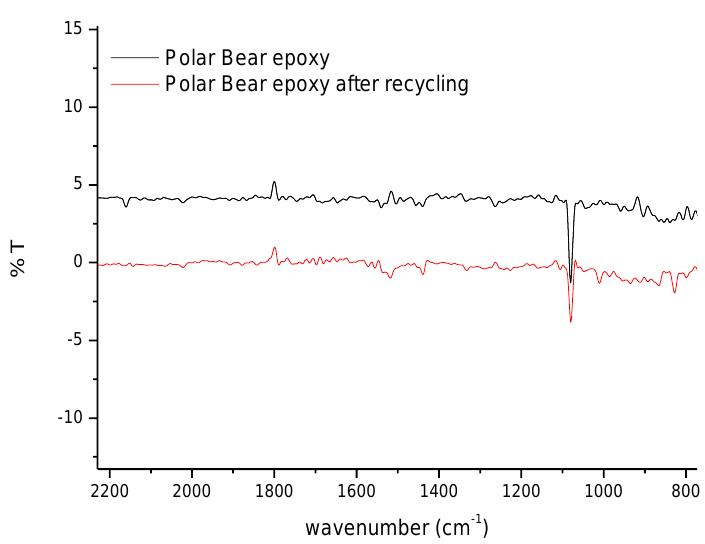
Figure 4. FTIR on EWF-based epoxy systems.